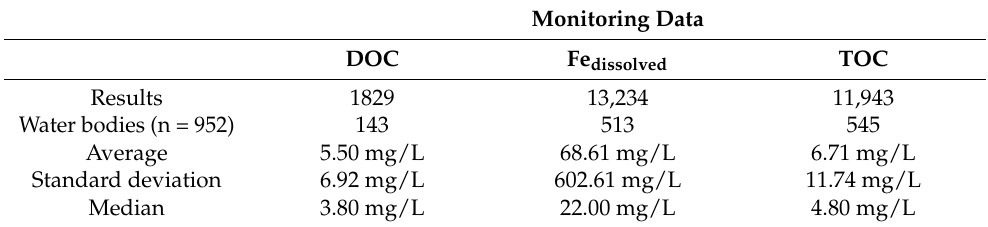
Table 1. The basic statistics of the monitoring data for the Bulgarian surface waters